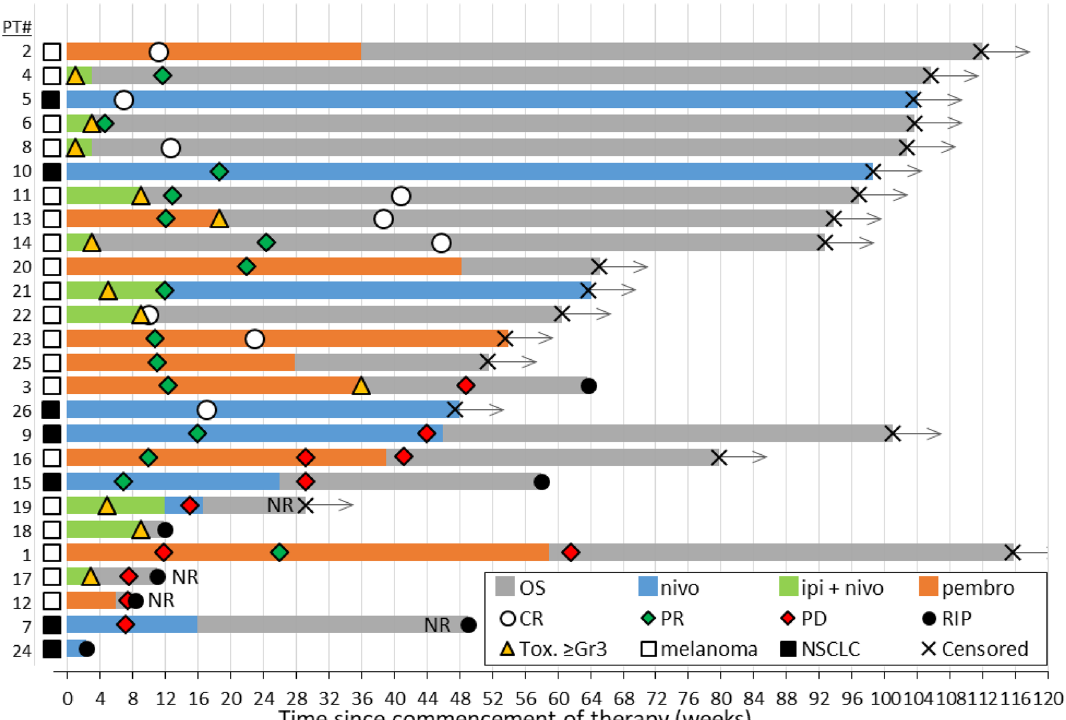
Figure 1. Swimmer plot showing individual patient characteristics with respect to time since commencement of therapy including: treatment type and duration, overall survival (OS), date of death (RIP) or censorship date, and timing of radiological responses of either complete response (CR), partial response (PR) or progressive disease (PD). Timing of toxicities of grade 3 or above are also noted. Patients are ordered time until either first recorded disease progression or time until censorship. NR non-responding patient. Patients 24 and 18 were not assessed for radiological